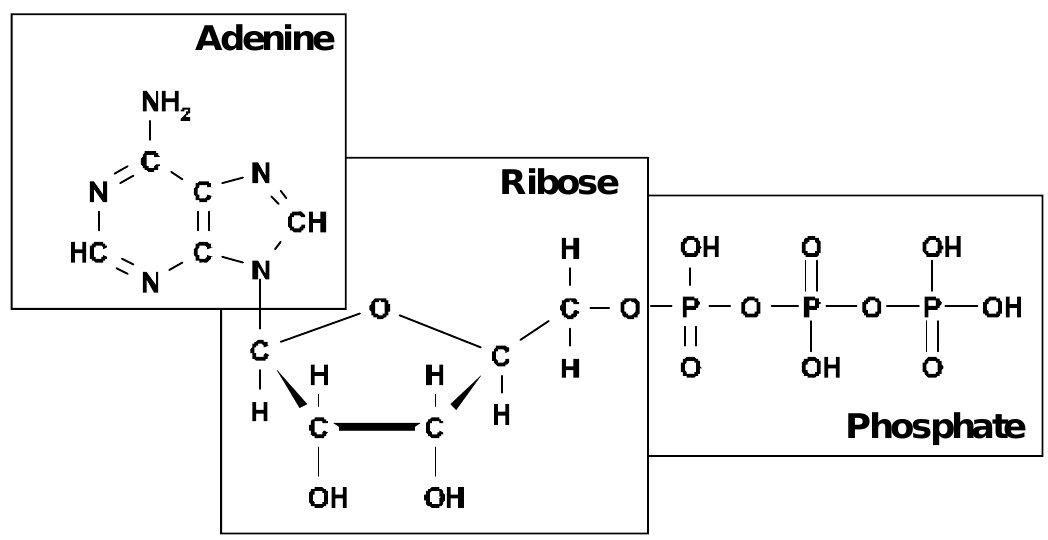
Figure 1. Adenosine